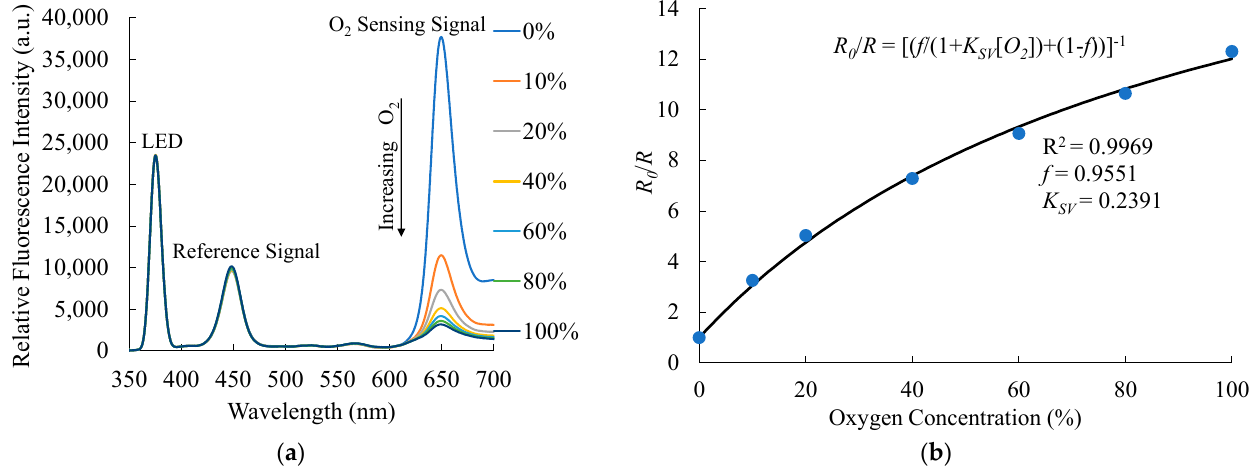
Figure 4. ( a ) Response of the optical dual sensor under exposure to different O 2 concentrations and ( b ) Stern-Volmer plots.